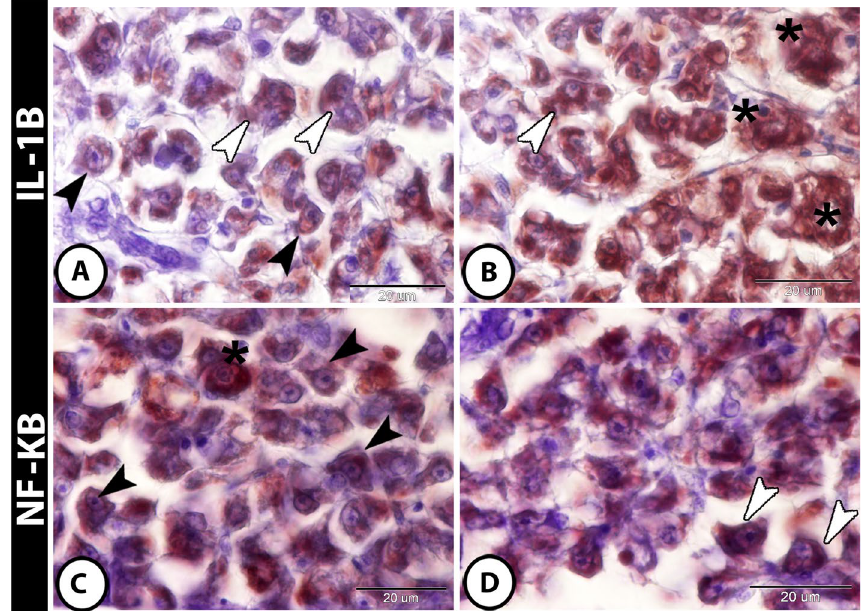
Fig. 4 Expressions of IL-1β and NF-κB in liver of molly fish. A and B IL-1β showed strong immunoreactivity in hepatocytes (black arrowheads), macrophages (white arrowheads) and in melanomacrophage center (asterisks). C and D NF- κ B was strongly expressed in hepatocytes (black